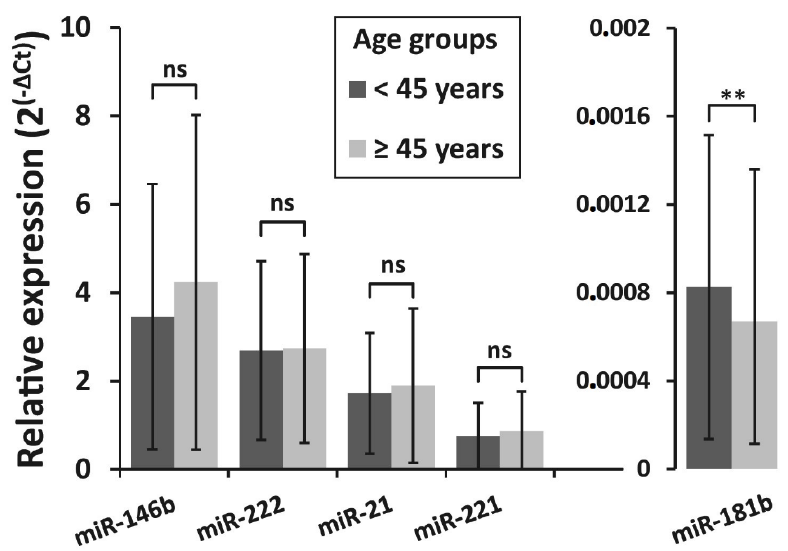
Figure 5. Relative expression of miR-146b, miR-222, miR-21, miR-221, and miR-181b in different age groups of PTC patients. All data are presented as the mean ± SD. ** p < 0.01. ns—not significant. The association of BRAF V600E mutation with patient’s age at diagnosis of PTC, primary tumor size and lymph node metastasis status were investigated (Figure 7). Patients of 45 years and older had the same frequency of BRAF V600E mutation as younger patients, whereas the significant di ff erence was found in analysis limited within age groups. In 45 years and older patients group, a higher proportion of patients had BRAF V600E mutation (64.2% vs. 35.8%, p = 0.002), whereas in the younger patients group the BRAF V600E positivity group did not significantly di ff er (58.5% vs. 41.5%, p = 0.122) (Figure 6A). Biomolecules 2020 , 10 , x FOR PEER REVIEW